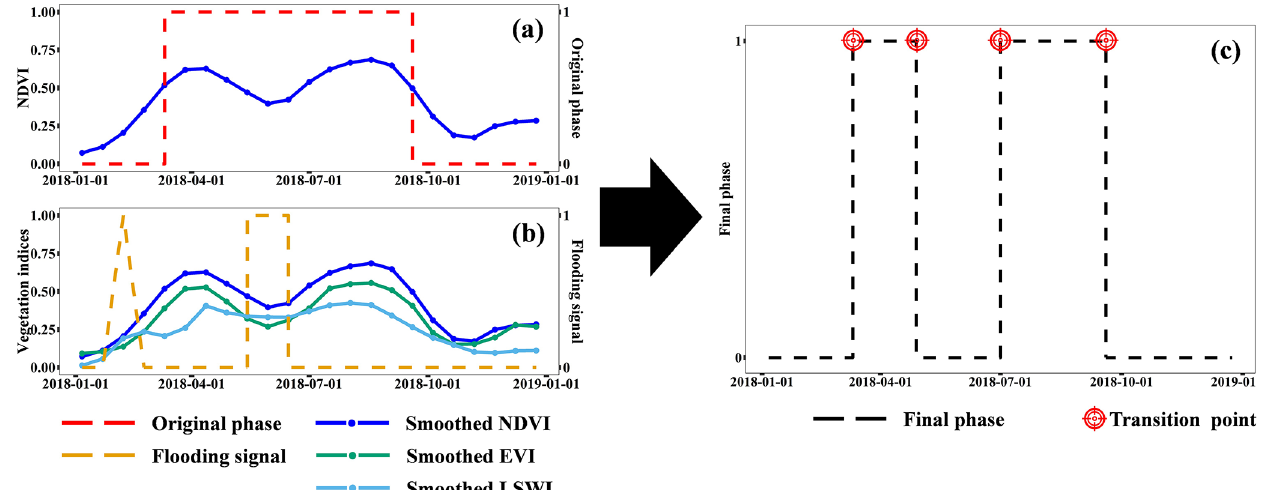
Figure 2. Illustration of the specific CI identification for a flooded rice paddy